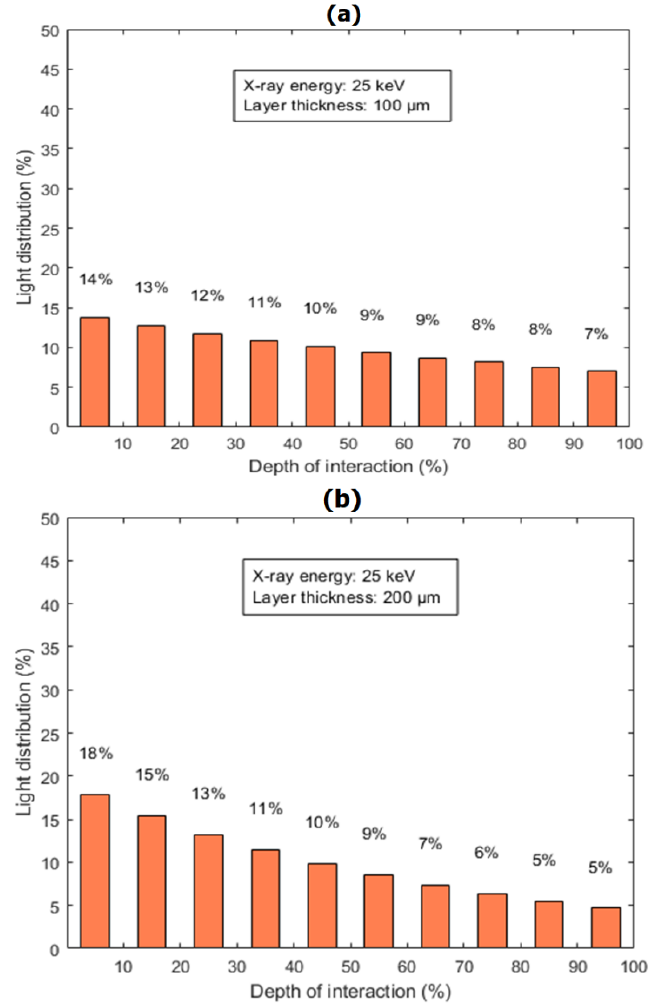
Figure 7. The light distribution (%) as a function of the depth of the interaction site (the percentage interaction depth with respect to the total screen thickness) within the phosphor layer of Gd 2 O 2 S phosphor material irradiated by an X-ray beam of 25 keV upon a phosphor layer of thickness: ( a ) 100 μm ( upper image ) and ( b ) 200 μm ( lower image ).